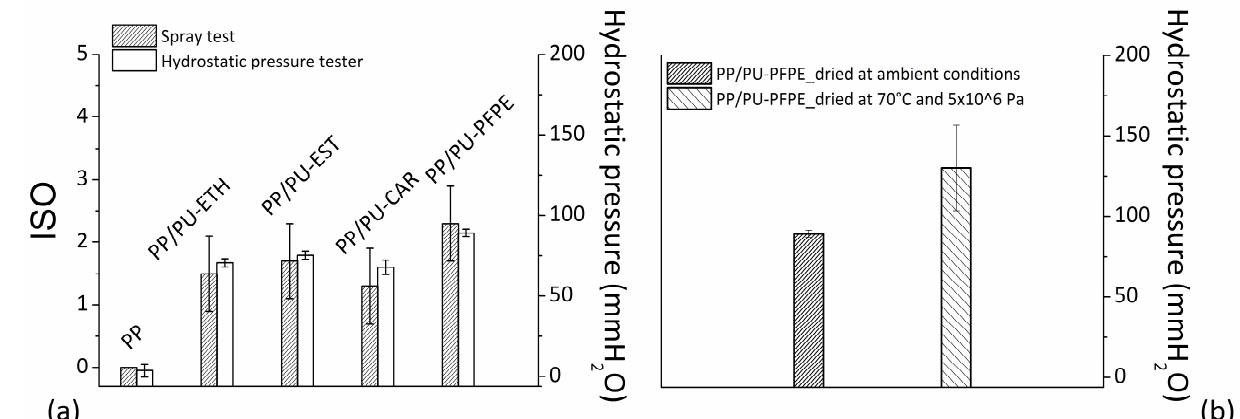
Figure 9. ISO index and hydrostatic pressure value for dried specimens at ambient conditions ( a ), and the effect of drying on hydrostatic pressure for PP/PU-PFPE ( b